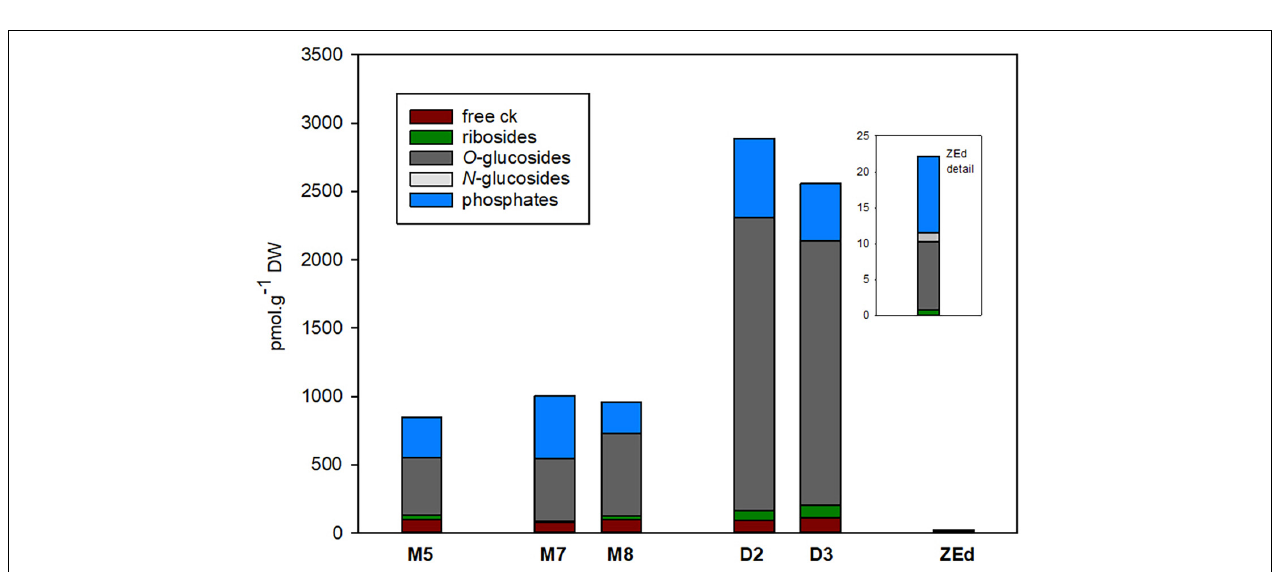
FIGURE 8 | Total content of cytokinin forms in P. abies somatic (SEs) and zygotic (ZEs) embryos. M5 – mature SEs after 5 weeks of maturation, M7 and M8 – SEs after 7 and 8 weeks of prolonged maturation, D2 and D3 – SEs after 2 and 3 weeks of desiccation, ZEd – dry ZEs.